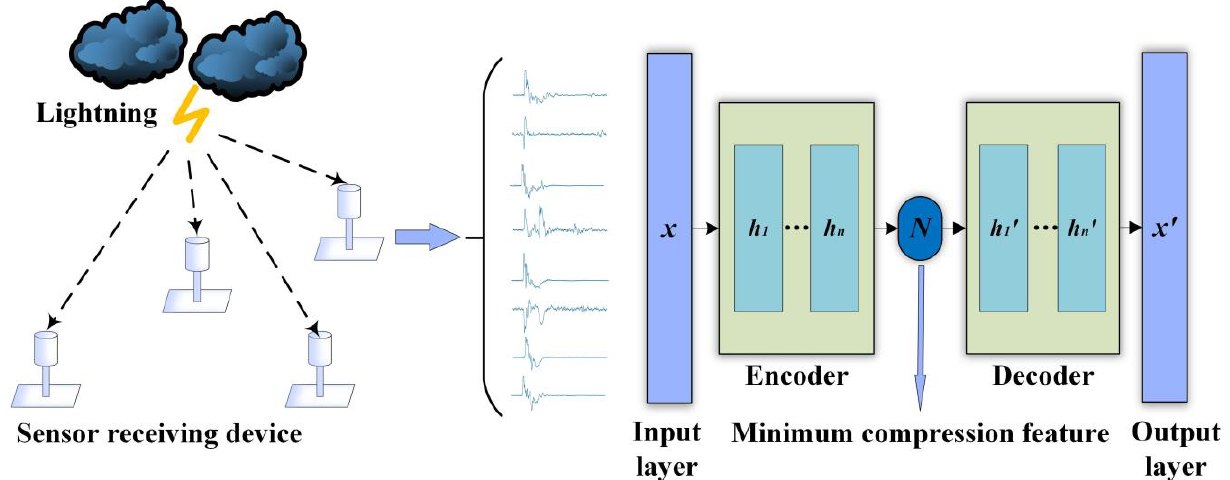
Figure 1. Schematic diagram of LCSAE waveform compression method.